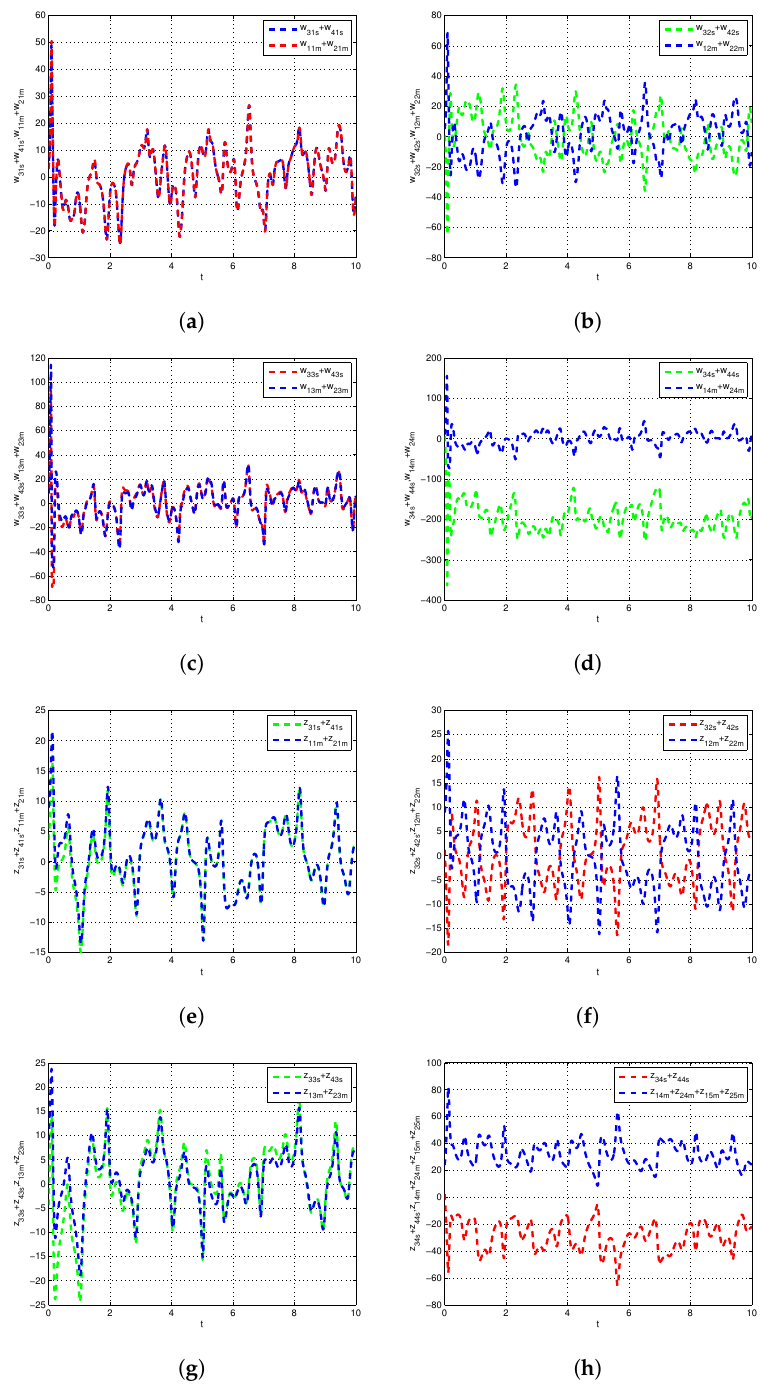
Figure 2. Trajectories of DCCHS of the master and slave state variables with controllers ( a ) between w 11 m ( t ) + w 21 m ( t ) − w 31 s ( t ) + w 41 s ( t ) , ( b ) between w 12 m ( t ) + w 22 m ( t ) − w 32 s ( t ) + w 42 s ( t ) , ( c ) be- tween w 13 m ( t ) + w 23 m ( t ) − w 33 s ( t ) + w 43 s ( t ) , ( d ) between w 14 m ( t ) + w 24 m ( t ) − w 34 s ( t ) + w 44 s ( t ) , ( e ) between z 11 m ( t ) + z 21 m ( t ) − z 31 s ( t ) + z 41 s ( t ) , ( f ) between z 12 m ( t ) + z 22 m ( t ) − z 32 s ( t ) + z 42 s ( t ) , ( g ) z 13 m ( t ) + z 23 m ( t ) − z 33 s ( t ) + z 43 s ( t ) , ( h ) z 14 m ( t ) + z 24 m ( t ) − z 34 s ( t ) + z 44 s ( t )